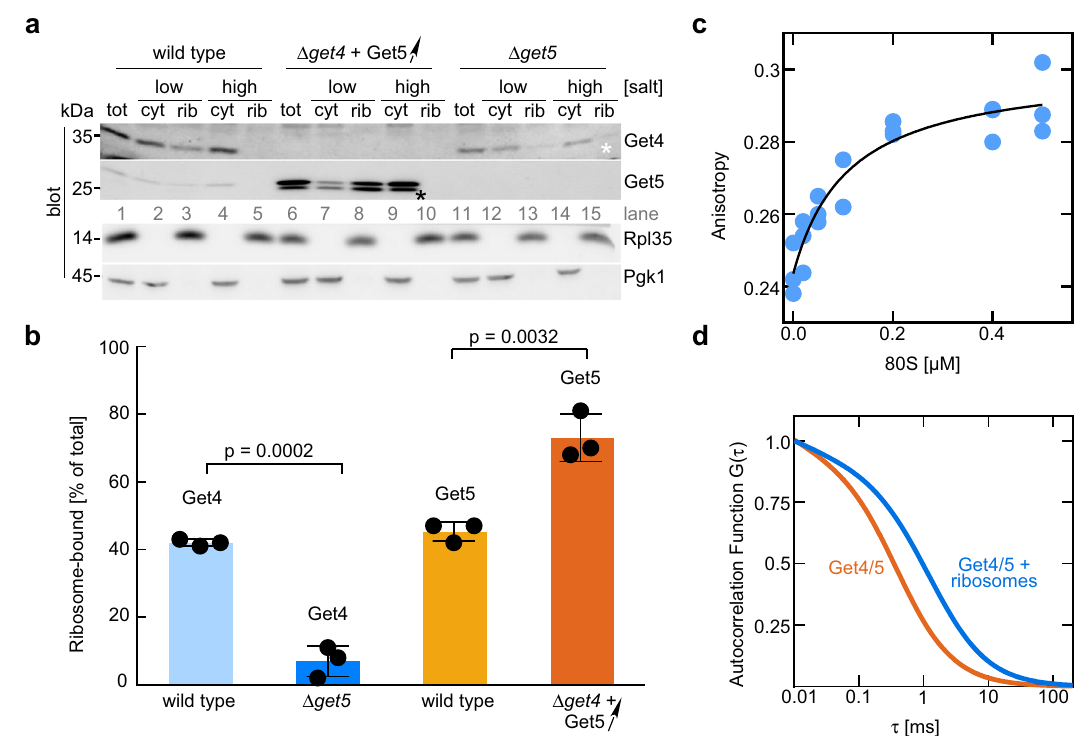
Fig. 1 The Get4/5 complex binds to ribosomes with high af fi nity. a The Get4/5 complex binds to ribosomes via Get5. Total cell extracts (tot) of wild type, a Δ get4 strain overexpressing Get5 ( Δ get4 + Get5 ↑ , Supplementary Fig. 1), or a Δ get5 strain were separated into a cytosolic fraction (cyt) and a ribosomal pellet (rib) under low salt (120 mM KOAc) or high salt (800 mM KOAc) conditions. The black asterisk indicates the fraction of overexpressed Get5 migrating with lower molecular mass, likely due to partial degradation of overexpressed Get5. The white asterisk indicates the fraction of aggregated Get4, which sediments together with ribosomes under high salt conditions in the absence of Get5. Aliquots were analyzed via immunoblotting with α -Get4, α -Get5, α -Rpl35 (ribosomal marker), and α -Pgk1 (cytosolic marker). b Quanti fi cation of the fraction of Get4 and Get5 bound to ribosomes. Given is the fraction of Get4 or Get5 recovered in low salt ribosomal pellets (rib) compared with the total (rib + cyt) based on the analysis of experiments as shown in a . Get4 or Get5 recovered in high salt ribosomal pellets was subtracted as a background. The results of each biological replicate are shown as black dots. Error bars indicate the standard deviation of the mean. Indicated p values were calculated using a two-sided Student ’ s t test with GraphPad Prism. c Get4/5 binds to puri fi ed 80S ribosomes with high af fi nity. Fluorescence anisotropy-based binding assays were performed with Get4/5-Atto390 (20 nM) and puri fi ed 80S ribosomes (see Methods). The data were fi t to a one site, saturation binding curve, from which the equilibrium dissociation constant and the standard error of the mean ( K d = 110 ± 40 nM) was determined using GraphPad Prism. d Get4/5 binding to the 80S ribosome monitored by FCS. Autocorrelation functions are represented for Get4/5-Atto655 alone (red) and in complex with the 80S ribosomes (blue). Concentrations of Get4/5- Atto655 and 80S ribosomes were 5 nM and 1 µ M, Get4/5 complex was puri fi ed, Get4 was labeled with a fl uorescent dye Atto390 (Get4/5-Atto390, see Methods) and the binding was monitored using the change of the anisotropy of the fl uorophore. Fluorescence anisotropy changes followed a saturation binding curve re fl ecting a single binding site with a K d of 110 ± 40 nM (Fig. 1c). To monitor the interaction between Get4/5 and the ribosome directly, single molecule fl uorescence correlation spec- troscopy (FCS) was used (Fig. 1d and Supplementary Table 1). FCS reveals the diffusion times of molecules as they move through the confocal volume of a microscope. As the 80S ribo- some (3.2 MDa 26 ) is much larger than Get4/5 (120 kDa, α 2 β 2 complex), the diffusion time of Get4/5 alone will be much faster than when it is in complex with the ribosome. For FCS experi- ments, Get4/5 was labeled with Atto655 and the diffusion prop- erties of Get4/5-Atto655 were studied with or without ribosomes. Fitting the FCS autocorrelation functions showed that in the sample with Get4/5-Atto655 alone, the majority of the molecules moved with an average diffusion time of 0.39 ms; a small fraction free dye (Supplementary Table 1). From the diffusion time of Get4/5-Atto655, we calculated a diffusion coef fi cient of 87 ± 2 μ m 2 s − 1 , which is close to the value of 70 μ m 2 s − 1 estimated